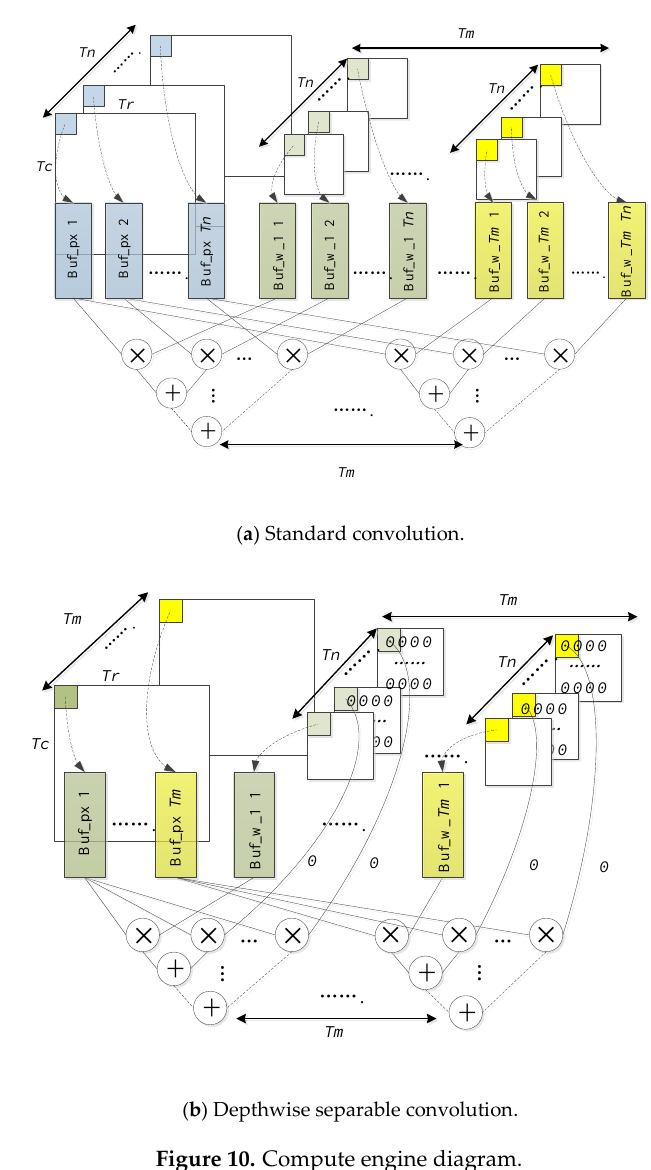
Figure 10. Compute engine diagram.